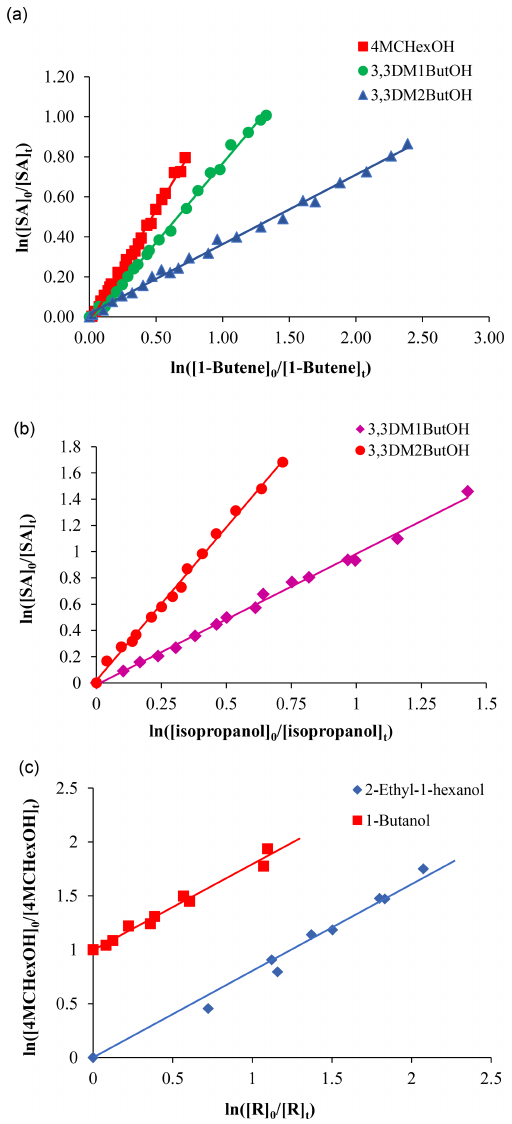
Figure 1. Relative rate plots for the reaction of (a) SAs with chlo- rine atoms, employing 1-butene as a reference compound; (b) 3,3- dimethylbutanol and the OH radical with isopropanol as a reference compound; and (c) 4MCHexOH and NO 3 with two reference com- pounds. Data for 1-butanol have been vertically displaced for clar-